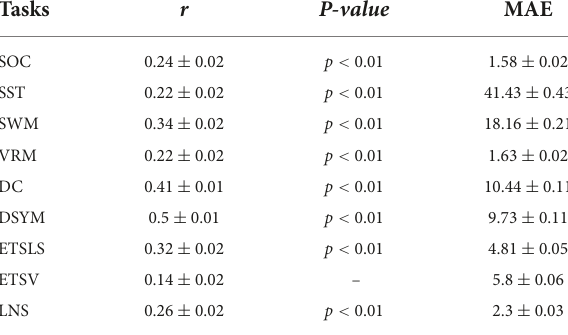
TABLE 1 Performance of white matter